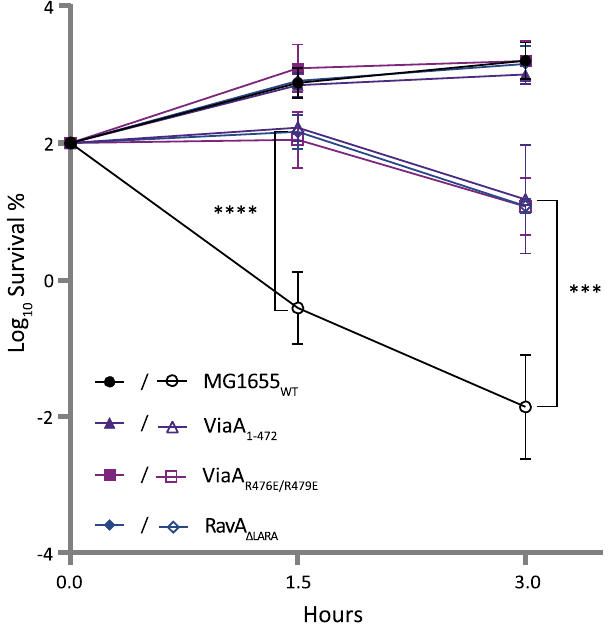
Fig. 6 | Lipid binding-de fi cient chromosomalmutantsofRavA and ViaA impair RavA and ViaA function in gentamicin sensitisation. Survival of wild-type MG1655, ViaA 1-472 , ViaA R476E/R479E and RavA Δ LARA E. coli strains after Gm treatment. Cells were grown to an OD 600 of 0.2 in LB supplemented with 10mM fumarate, after which 16 µ g/mL Gm was added. The survival values after 1.5 and 3h of treat- ment are represented. Full and empty symbols are for untreated and Gm-treated bacteria, respectively. Survival, measured by colony-forming units (CFU) per mL, wasnormalized relative totimezero atwhich Gm wasadded (early logphase cells; ~5×10 7 CFU/mL)andplottedasLog 10 of%survival.Valuesareexpressedasamean valueof3biologicalreplicatesanderrorbarsdepictstandarddeviations.Aone-way ANOVA test followed by a Dunnett ’ s multiple comparisons test was performed to compareateachtimepoint(1.5&3h)thetreatedWTtoeachofthetreatedmutant strains(***adjusted p value=0.0002&****adjusted p value<0.0001).Sourcedata are provided as a Source Data fi